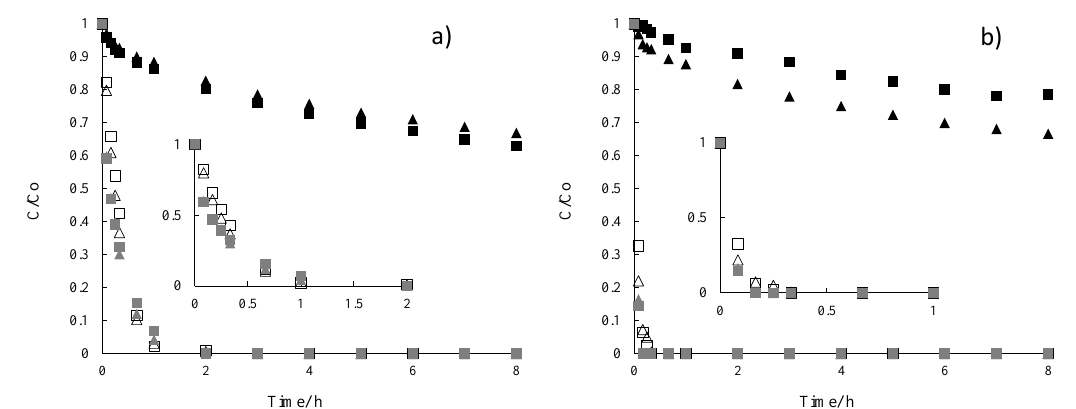
Figure 3. Degradation trends of AMX (triangles) and AMP (squares) during the electrolysis (∆, ), photolysis ( ▲, ) and photoelectrolysis ( ▲ , ) tests in sulphate media ( a ) and chlorine ( b ). Initial concentration: 100 mg L -1 of AMX and 100 mg L -1 of AMP. Electrolyte concentrations: 3 g L -1 of Na 2 SO 4 or 3.7 g L -1 of NaCl. Current density: 30 mA cm -2 : UV light: 254 nm.